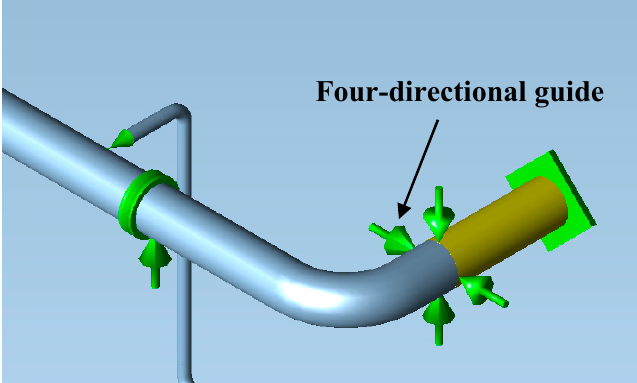
Figure 16. Numerical simulation model of four-directional guide in CAESAR II software.